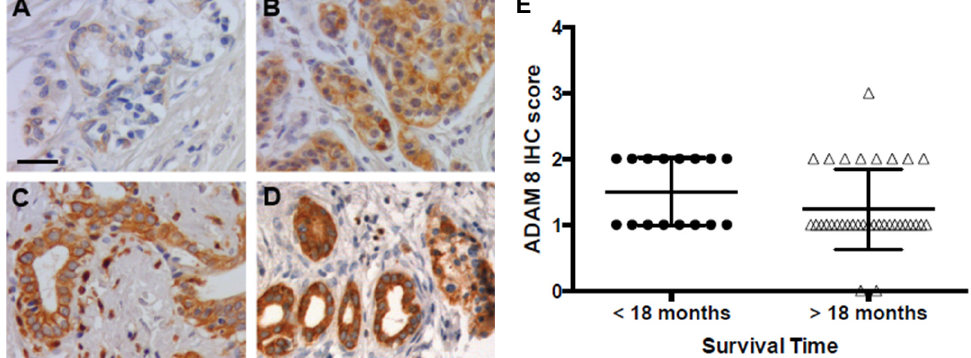
Figure 1. Correlation of ADAM8 staining scores with survival in patients of the PDAC cohort ( n = 50). Four exemplary images illustrating varying levels of ADAM8 staining in patient samples. The scale bar is 25 μ m. Staining intensities were determined for each section based on analysis of 5 viewing fields per section and were between 0 and 3 with no (0; ( A )), low (1; ( B )), moderate (2; ( C )) and strong (3; ( D )) ADAM8 staining. ( E ): Patients in the cohort were split into 2 groups with group 1, survival less than 18 months (•; n = 16) and group 2 ( Δ ; n = 34), patient survival longer than 18 months. Note that only two PDAC sections were almost negative for ADAM8. Difference is not significant.